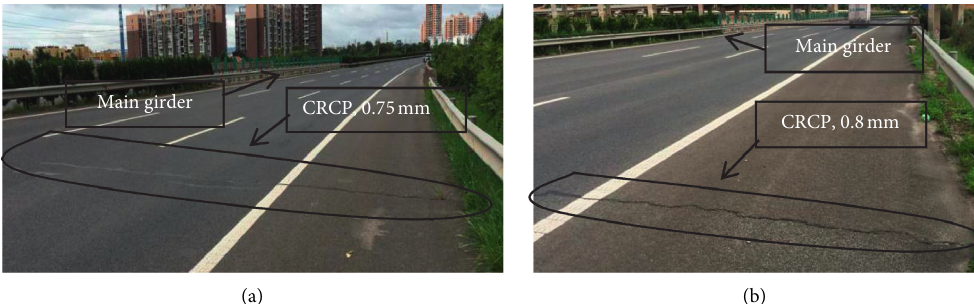
Figure 2: Photos of cracks in CRCP during service of fully jointless bridge: (a) Lihecun fully jointless bridge (in Feb 2019) and (b) Xinrong No.1 fully jointless bridge (in Feb